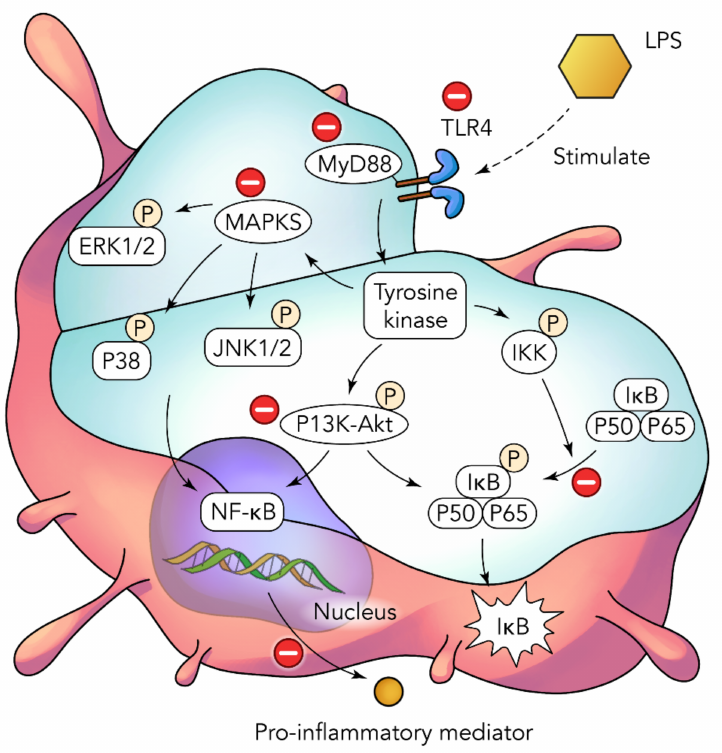
Figure 4. The schematic illustration of the potential mechanism of zerumbone in the suppression of LPS-stimulated inflammatory response in a macrophage